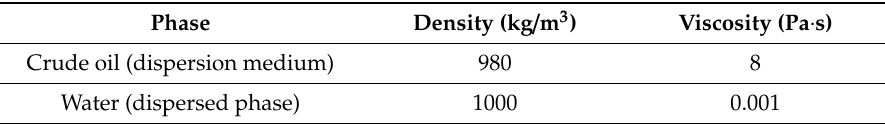
Table 2. Properties of the emulsion components.